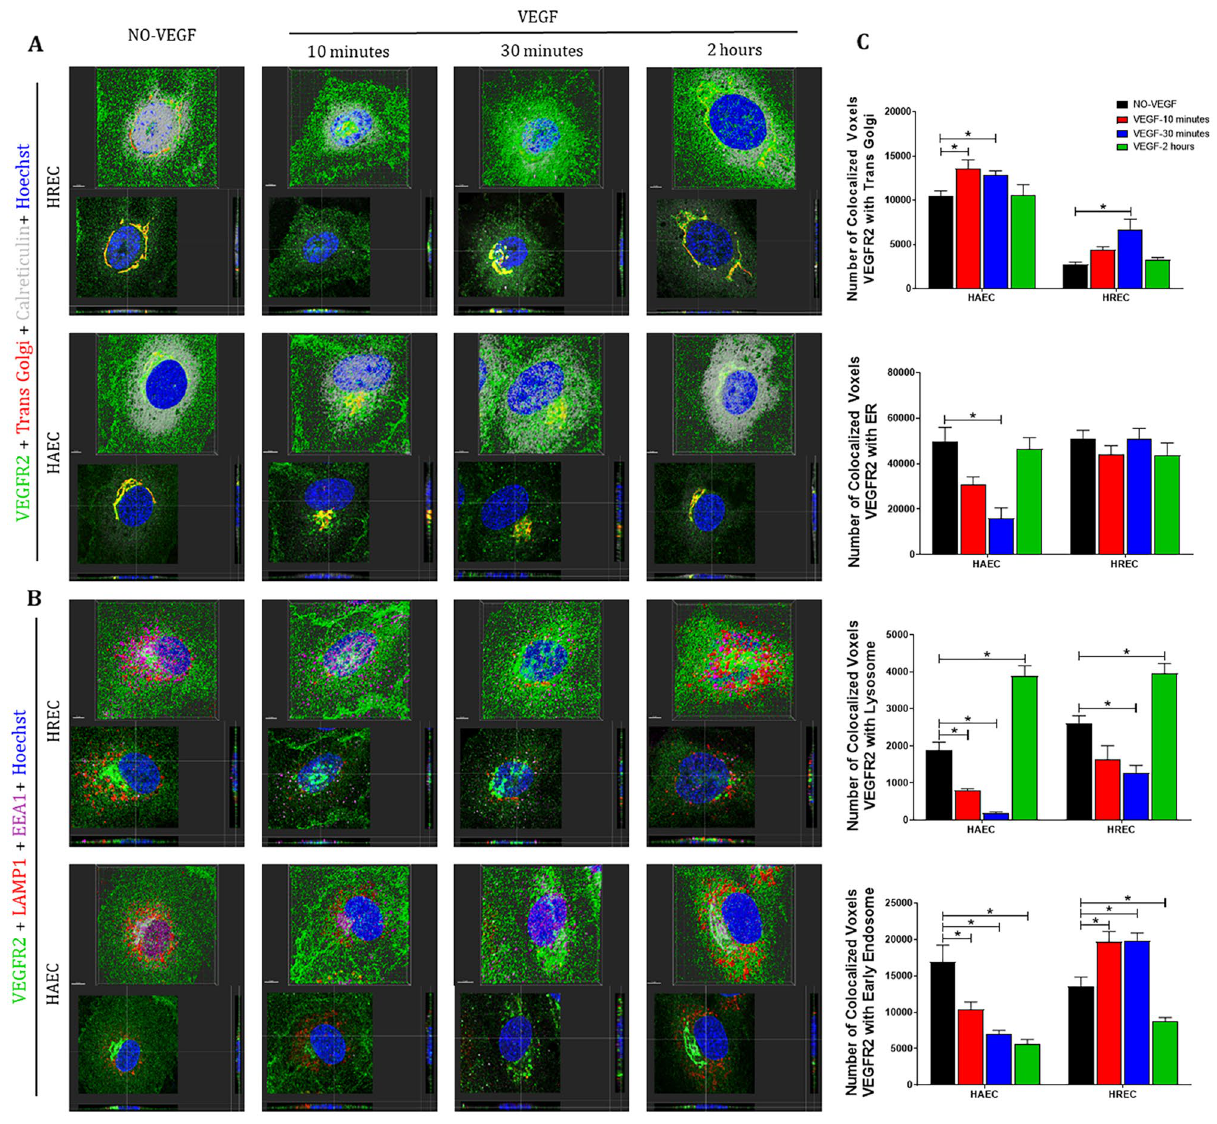
Figure 5. VEGFR2 can translocate from plasma membrane and intracellular compartments to the nucleus via early endosomes following VEGF treatment in endothelial cells . Intracellular trafficking of VEGFR2 in HREC and HAEC was evaluated by immunofluorescence at different time points (10 min, 30 min and 2 h) after exposure to 100 ng/ml VEGF and compared to saline controls (NO-VEGF). Triple immunofluorescence was performed to colocalize VEGFR2 with specific organelles. ( A ) 3D reconstruction rendering of the HREC and HAEC immunostained with VEGFR2 (green), trans Golgi (red) and calreticulin (endoplasmic reticulum-ER gray) ( B ) 3D reconstruction rendering of HREC and HAEC immunostained with VEGFR2 (green), LAMP1 (lysosome-red) and EEA1 (early endosome-magenta). The nuclei in ( A ) and ( B ) were fluorescently stained with the DNA intercalating dye Hoechst (blue). The colocalization points between green and red are shown in yellow and between green and magenta shown in gray. The top image of each block shows the 3D rendering of the representative cells of each time point and the same cells are shown in the lower image of each block showing the position of the nuclear translocation of VEGFR2 in only one focal plane in the center and the correlation of this point located in the 3D lateral and lower cross sections. Scale bars = 5 μm. ( C ) Quantification of the number of VEGFR2 colocalized voxels with the organelles relative to the number of cells in each image. The results show the analyzes of at least 10 confocal z-stack images at 400 × magnification for each time point by Imaris software and summarize the data obtained by quantifying the organelles from a minimum of 3 separate experiments from 3 donors of the HREC and 2 donors of the HAEC. The results show that the colocalization of VEGFR2 with trans Golgi and early endosomes increases between 10 and 30 min after VEGF treatment compared to control and correlates with the increase of VEGFR2 in the nucleus in HREC, but not in HAEC. * = p < 0.05 as determined by 1-way ANOVA and multi-comparison post-hoc Tukey’s test is considered